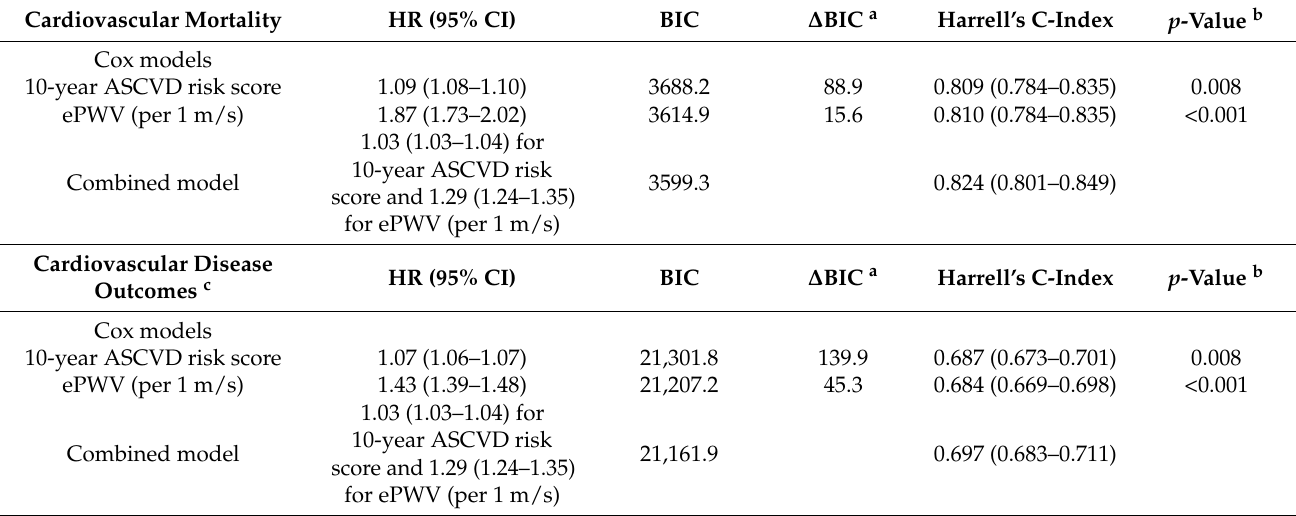
Table 3. Performances and comparisons between Cox proportional hazard models for cardiovascular